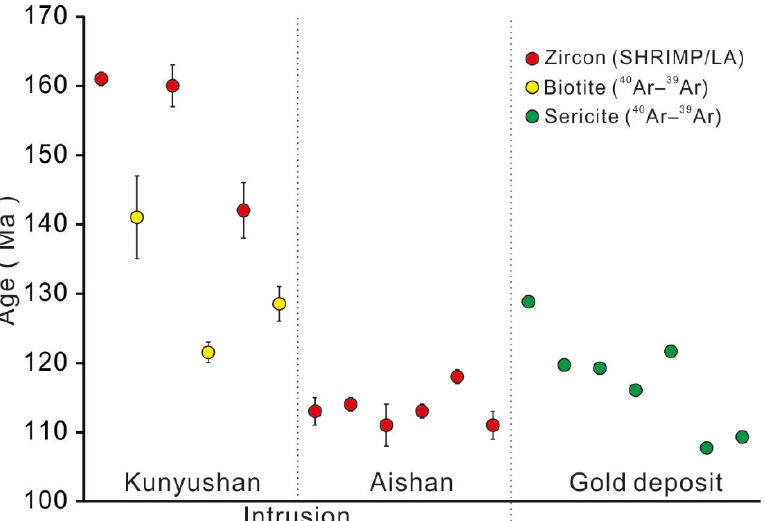
Figure 6. Time limit of gold mineralization in comparison to the magmatism in the Muping–Rushan gold belt (data are from [1,24,29,50–52]).